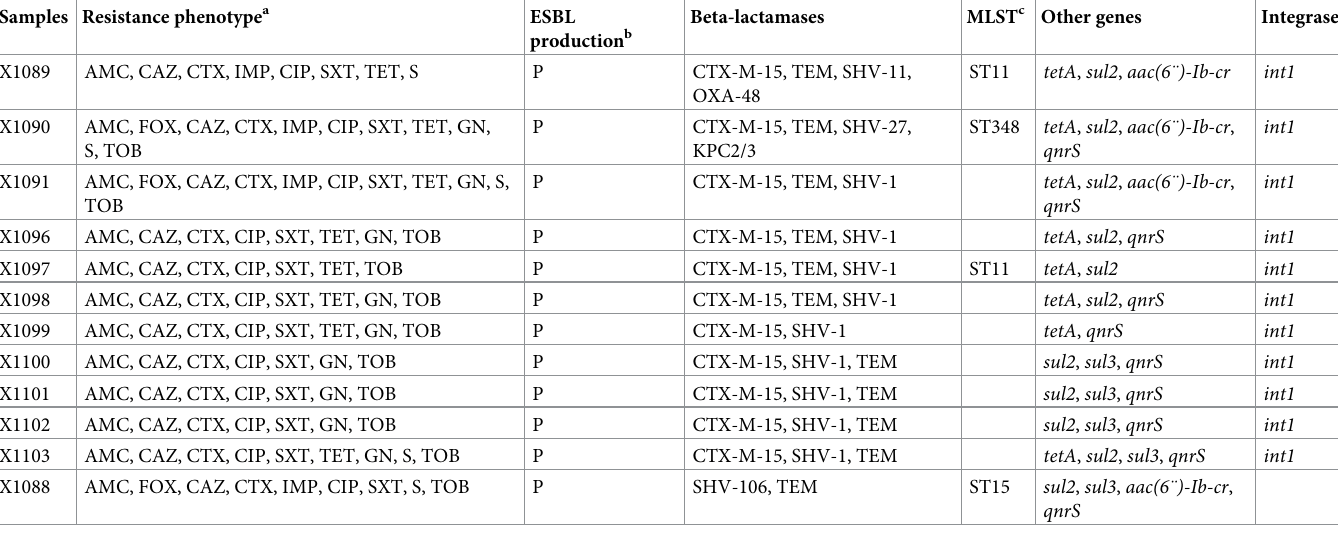
Table 1. Resistance phenotype and genotype present in K . pneumoniae isolates from human septicemias in Portugal. Samples Resistance phenotype a ESBL Beta-lactamases MLST c Other genes production b